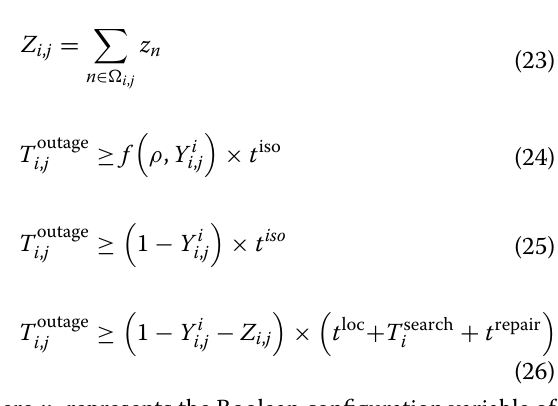
where y n represents the Boolean configuration variable of the I-type switch corresponding to the n th configuration position on the feeder. Y switches corresponding to figuration positions between fault i and load j . Z i , j is the number of V-type switches corresponding to